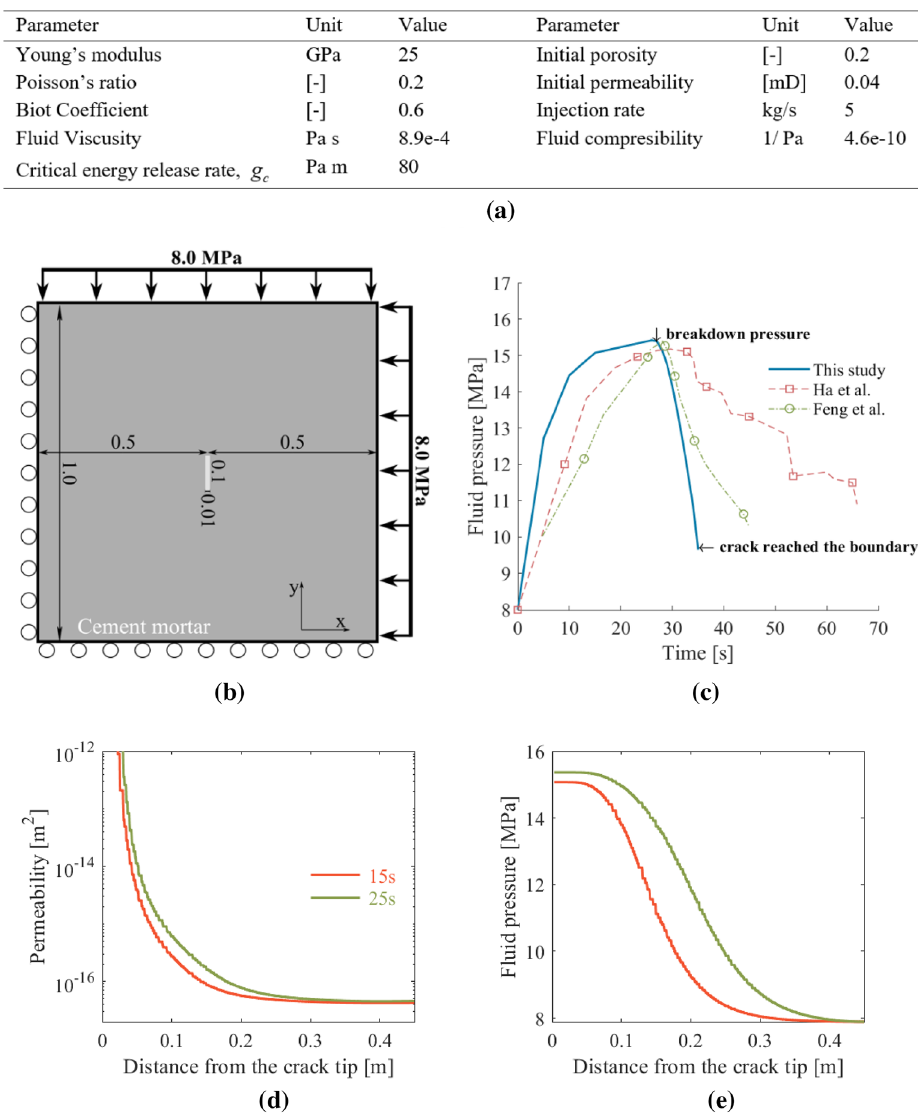
boundary conditions corresponding to hydraulic fracturing of cement mortar using water injection at the middle of the domain within a pre-existing fracture. ( c ) Computed pressure profile within the hydraulic fracture within the cement mortar, compared with the results by 44 and 43 . ( d ) Permeability and ( e ) pressure profile at 15 s and 25 s of water injection. The profile is along the y-axis, starting from the fracture tip to the top boundary. As the pressure approaches the breakdown pressure, the phase field around the initial fracture increase towards 1 to enable fracture nucleation and growth. The permeability equally increases following Eq. (20). As a result, the pressure profile flatters close to the breakdown. Note that the change in permeability is more pronounced than it appears in the figure as it is displayed in the log